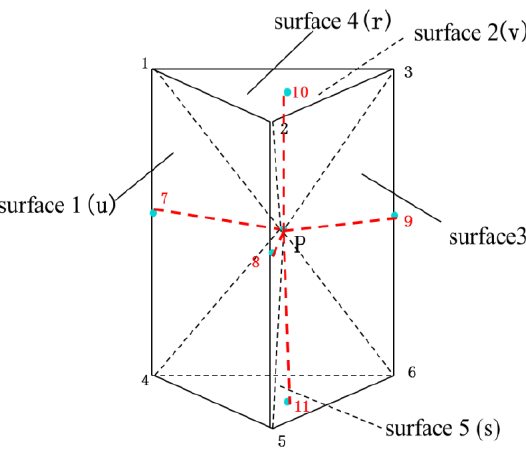
Figure 4. Triangular prism linear interpolation principle diagram.